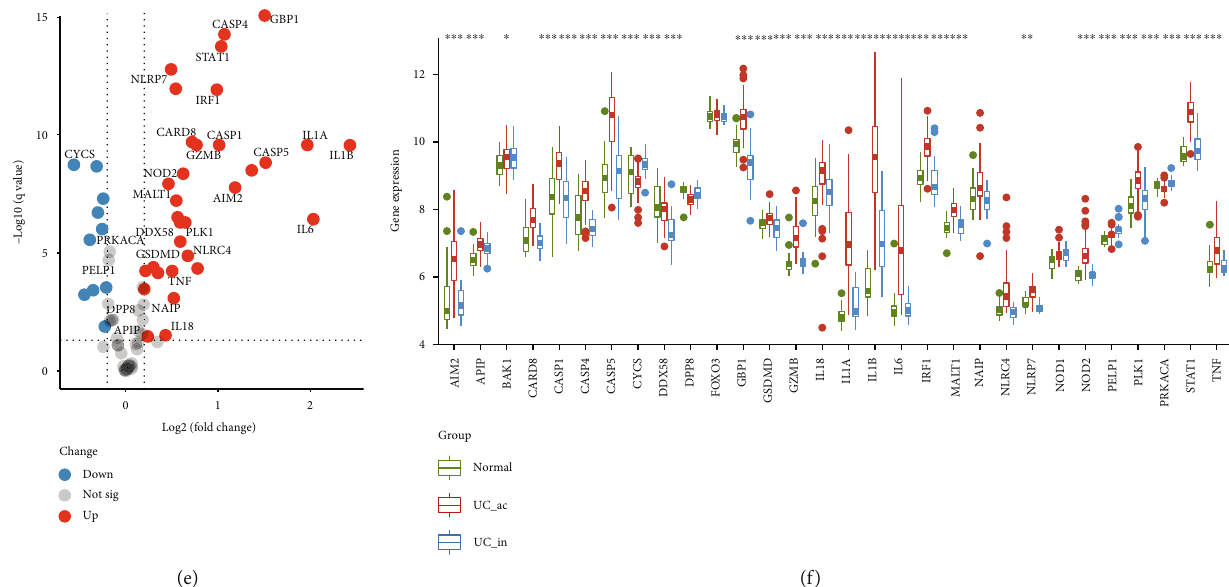
Figure 2: Landscape of immune status and pyroptosis-related genes (PRGs) in UC. (a) The distributions of 28 immune cells in normal and active/inactive UC samples. Red represents abundant in fi ltration and blue represents immune cell desert. (b) GSVA showed the distributions of the in fl ammation-related pathways in normal and active/inactive UC samples. Red represents activation of biological pathways and blue represents inhibition of biological pathways. (c) The volcano plot displayed the expression changing information of 75 PRGs between active UC and inactive UC samples in the training set. (d) Expression distributions of the 30 altered PRGs in normal and active/inactive UC samples in the training set. (e) The volcano plot showed the expression changing information of 75 PRGs between active UC and inactive UC samples in GSE75214. The marked genes are the 30 altered PRGs in the training set. (f) Expression distributions of the 30 altered PRGs in normal and active/inactive UC samples in GSE75214. UC: ulcerative colitis; ac: active; in: inactive. ∗ P < : 05 , ∗∗ P < : 01 , ∗∗∗